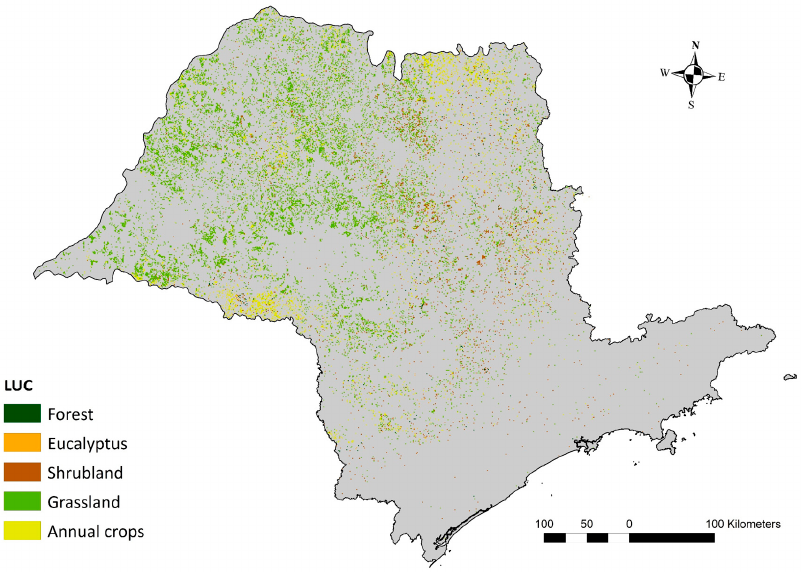
Figure 1. Land use / cover types replaced by sugarcane between 2004 and Figure 1. Land use/cover types replaced by sugarcane between 2004 and 2015.